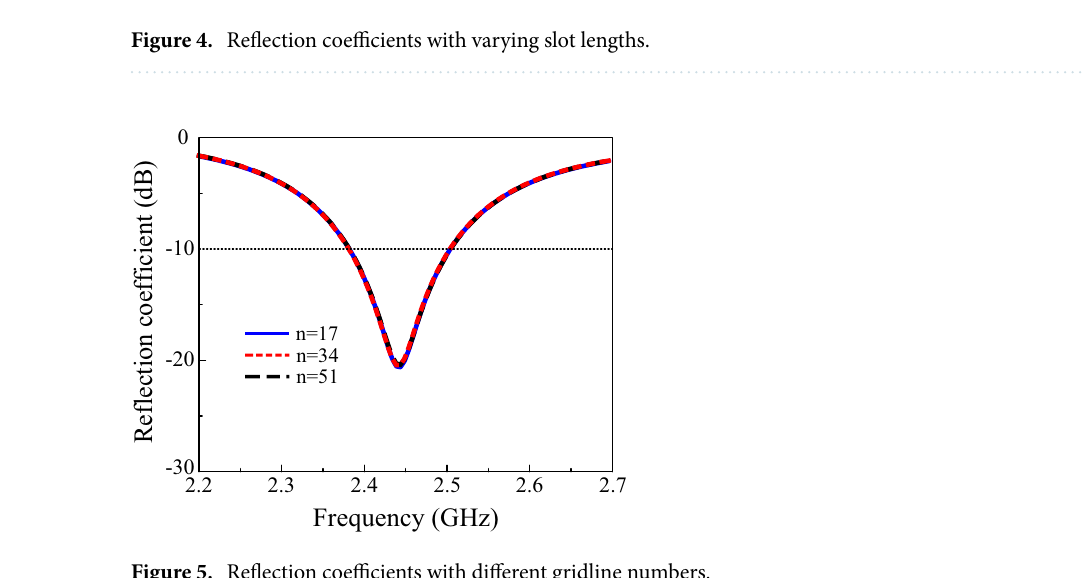
Figure 5. Reflection coefficients with different gridline numbers.